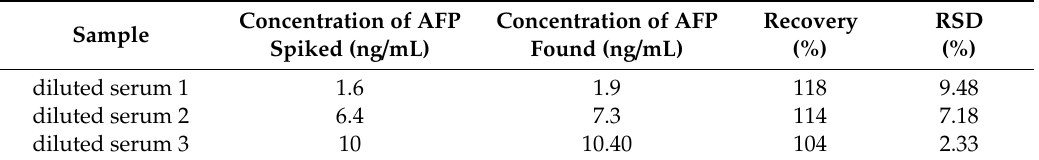
Figure 4. Sensitivity and selectivity of as-prepared Au NR-QDs apta-sensor for AFP detection. ( A ) Normalized fluorescence spectra of Au NR-QDs apta-sensor incubated with di ff erent concentrations of AFP from 0 to 10 ng / mL, where the maximum fluorescence intensity of Au NR-QDs apta-sensor was regarded as 1.0. ( B ) The relative fluorescence intensities ( F / F 0 ) against the AFP concentration exacted from ( A ). ( C ) The variation of F / F 0 for Au NR-QDs apta-sensor treated with PBS (blank), bull serum albumin (BSA, 1 µ g / mL), glucose (100 ng / mL), and AFP (10 ng / mL), respectively. The asterisks indicated the significant di ff erences between blank and experiment groups (*** p < 0.001, n.s. p > 0.05). ( D ) Detection of AFP in spiked human serum with as-prepared Au NR-QDs apta-sensor. The relative fluorescence intensities ( F / F 0 ) showed a similar negative relationship against AFP concentration in human serums. The inset is the picture of human serum. Table1. Theapplicationofgoldnanorods-quantumdots(AuNR-QDs)apta-sensorforthedetermination of serum samples spiked with di ff erent concentrations of alpha fetoprotein